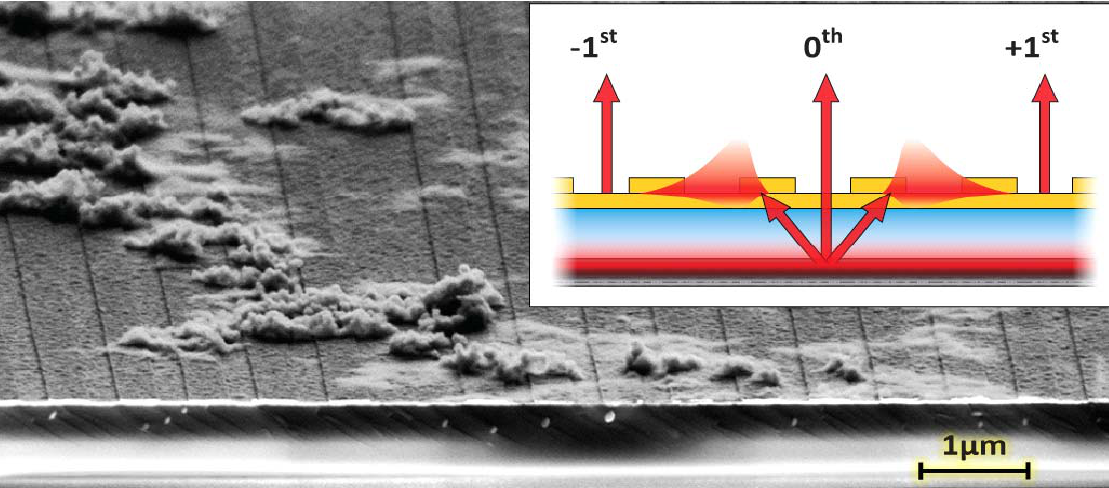
Figure 1. Working principle of the quantum well-surface plasmon resonance (QW-SPR) device. The SEM image presents a grazing angle view of a device sequentially exposed to solutions of neutravidin, biotinylated polyclonal IAV-H3N2 antibodies and capsids of IAV-H3N2. The Au grating is visible on the surface, under which a SiO layer is deposited 2 atop the GaAs-AlGaAs QW. Inset: Broadband and uncollimated NIR light is emitted from the QW to couple a continuum of SP modes on the surface, since conditions for SPR are concurrently met for a range of E(k ). The propagating modes can then diffract, mainly ll through the ±1st orders, to be measured by the microscope [9].